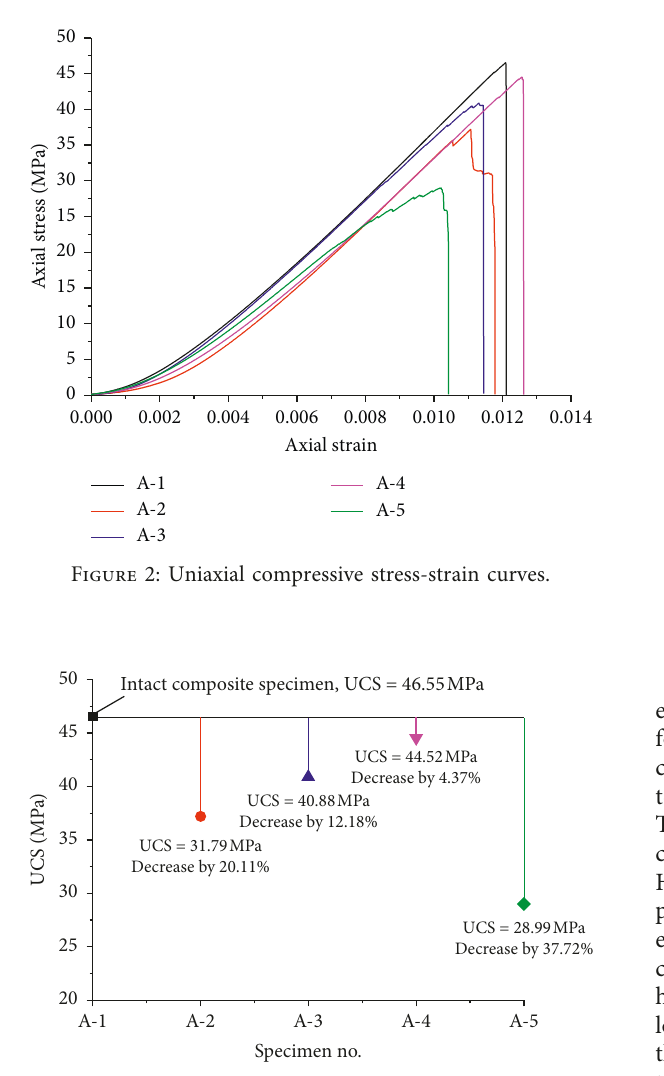
Figure 3: UCS comparison.